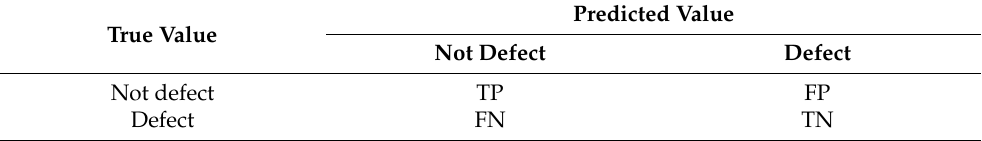
Table 3. Confusion